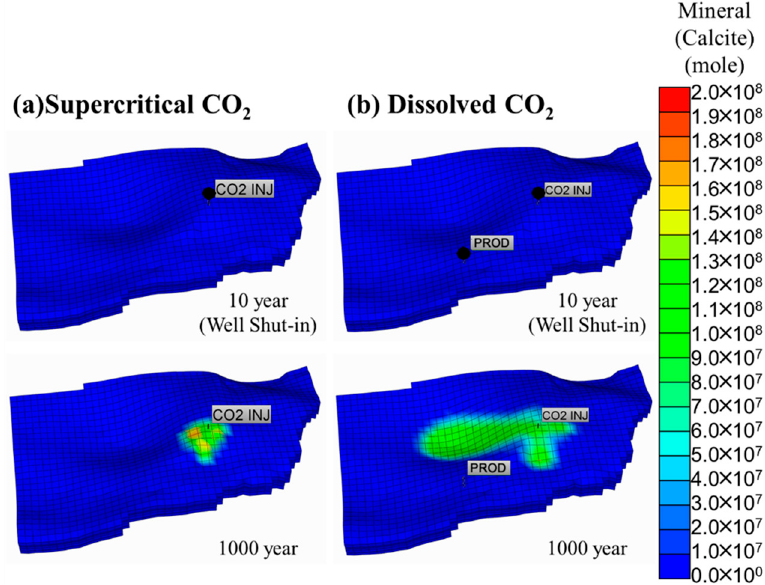
Figure 15. Comparison of the spatial distribution of the change in moles of calcite between scenarios.